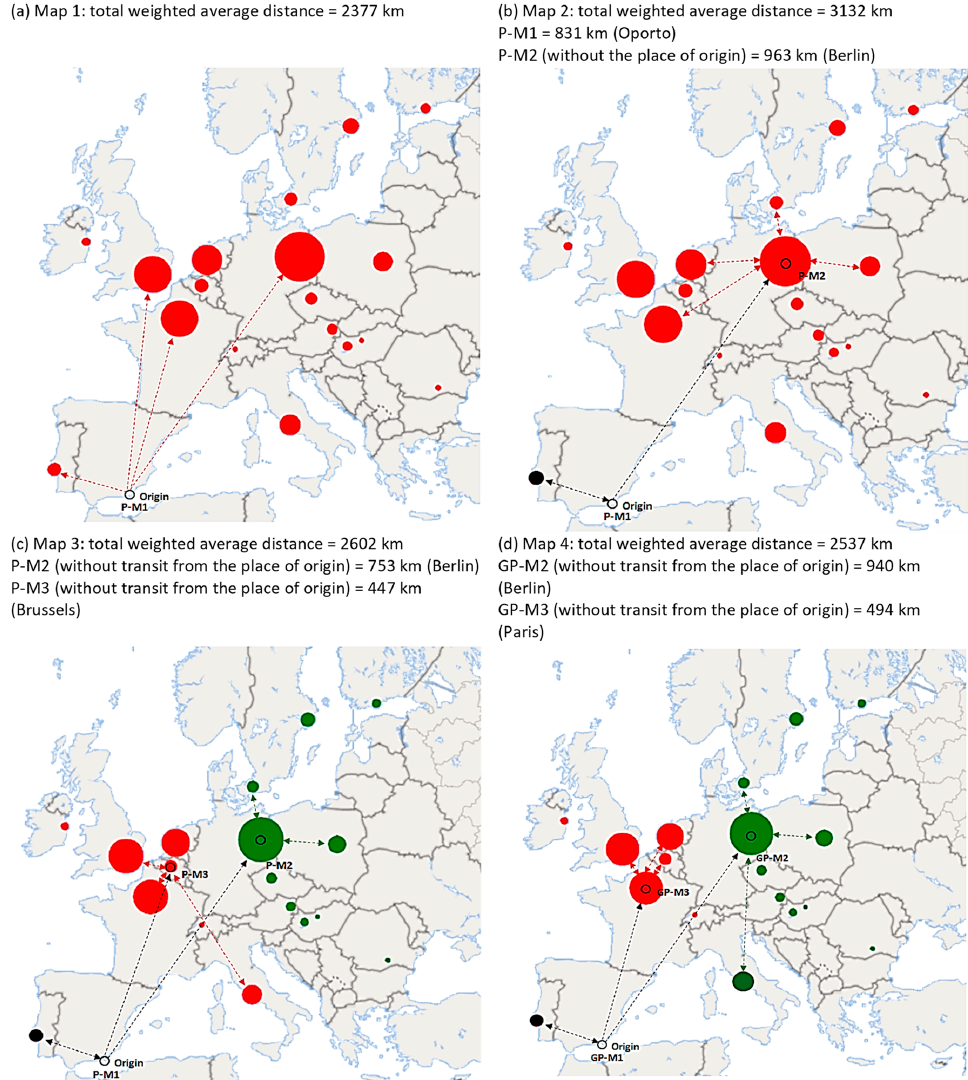
Figure 3. Results of the p-median (maps a – c ) and gravity p-median models (map d ). Lines: only samples of routes are shown. Each color represents customer allocation by the redistribution center. Source : own elaboration.